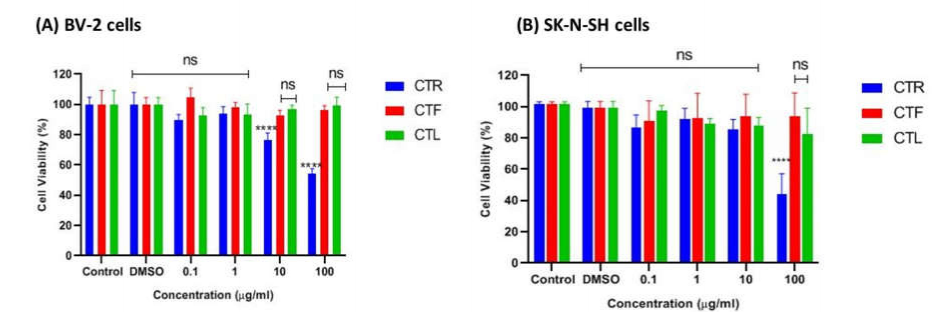
Figure 2. Cytotoxic effect of different parts of C. ternatea extracts (CTR, CTF, and CTL) on viability of ( A ) BV-2 microglial and ( B ) human neuroblastoma SK-N- SH cells after 24 h. Percentage cell viability is expressed as mean ± SD of three independent experiments. The value is statistically significant **** ( p < 0.0001) compared to the untreated cells; ns means not significant.